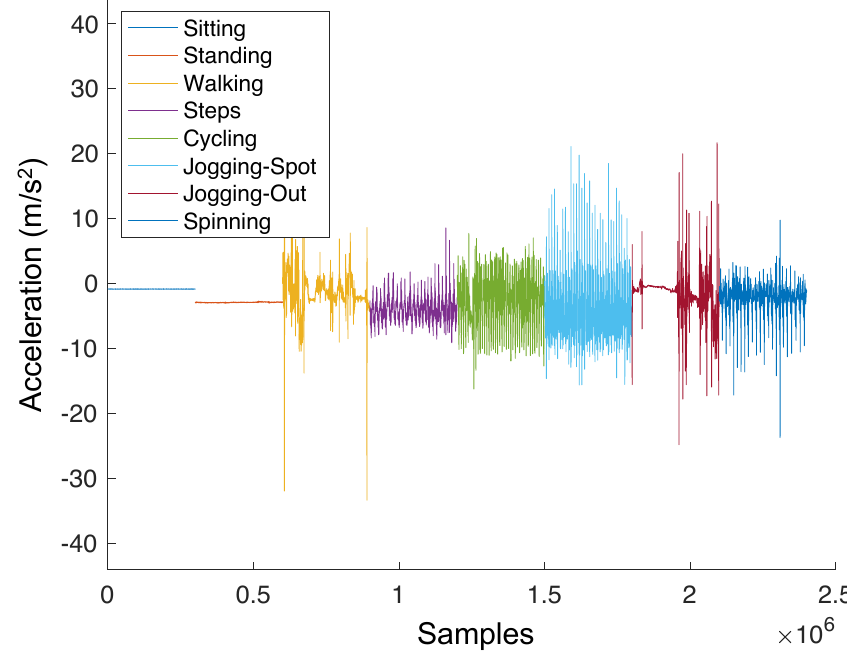
Figure 2. Accelerometer x-axis sensor data corresponding to each of the activities. The accuracy of a sensor depends on factors including the digital quantization, trans- ducer quality, signal conditioning fidelity as well as environmental conditions. If two or more sensors are sufficiently separated the noise will be uncorrelated and improvements made by averaging. Accelerometer noise is inversely proportional to the square root of the number of sensors. Therefore noise is reduced by a factor of two by averaging over four sensors. Measures such as applying a low-pass filter can also reduce the noise but can add lag and reduce the responsiveness. Combining information from two different types of sensor such as angular-velocity and magnetic-field can be beneficial as the sensor noise will be